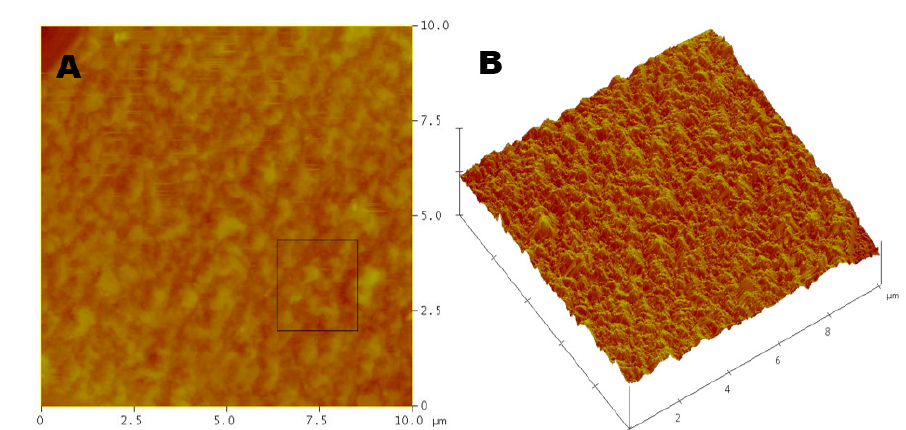
Figure 3. Atomic force microscopy of aluminum post-electropolishing with the ionic liquid in both ( A ) two and ( B ) three dimensions—recording an average roughness of 26 ± 2 nm by utilizing the root mean square method for calculation. A 10 × 10 µm recording region was utilized.